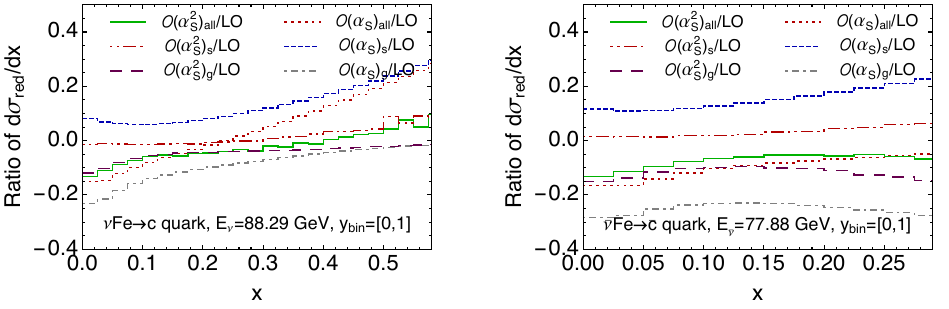
Figure 3 . QCD corrections at di(cid:11)erent orders separated into partonic channels for a di(cid:11)erential reduced cross section in Bjorken x for charm (anti-)quark production from (anti-)neutrino scattering on iron